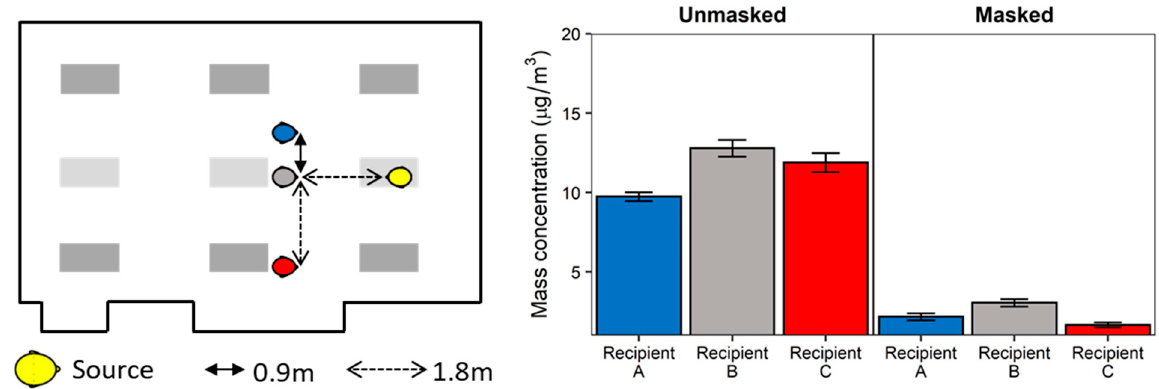
Figure 3. Speaker Source configuration. The Source and Recipients were positioned in a single scenario as shown in the diagram. The HVAC system ventilation was set to 4 ACH. Mean mass concentrations were measured at the Recipient breathing simulator for unmasked and universal masking experiments. Data are presented as the mean of four independent experiments. Error bars represent one standard deviation.